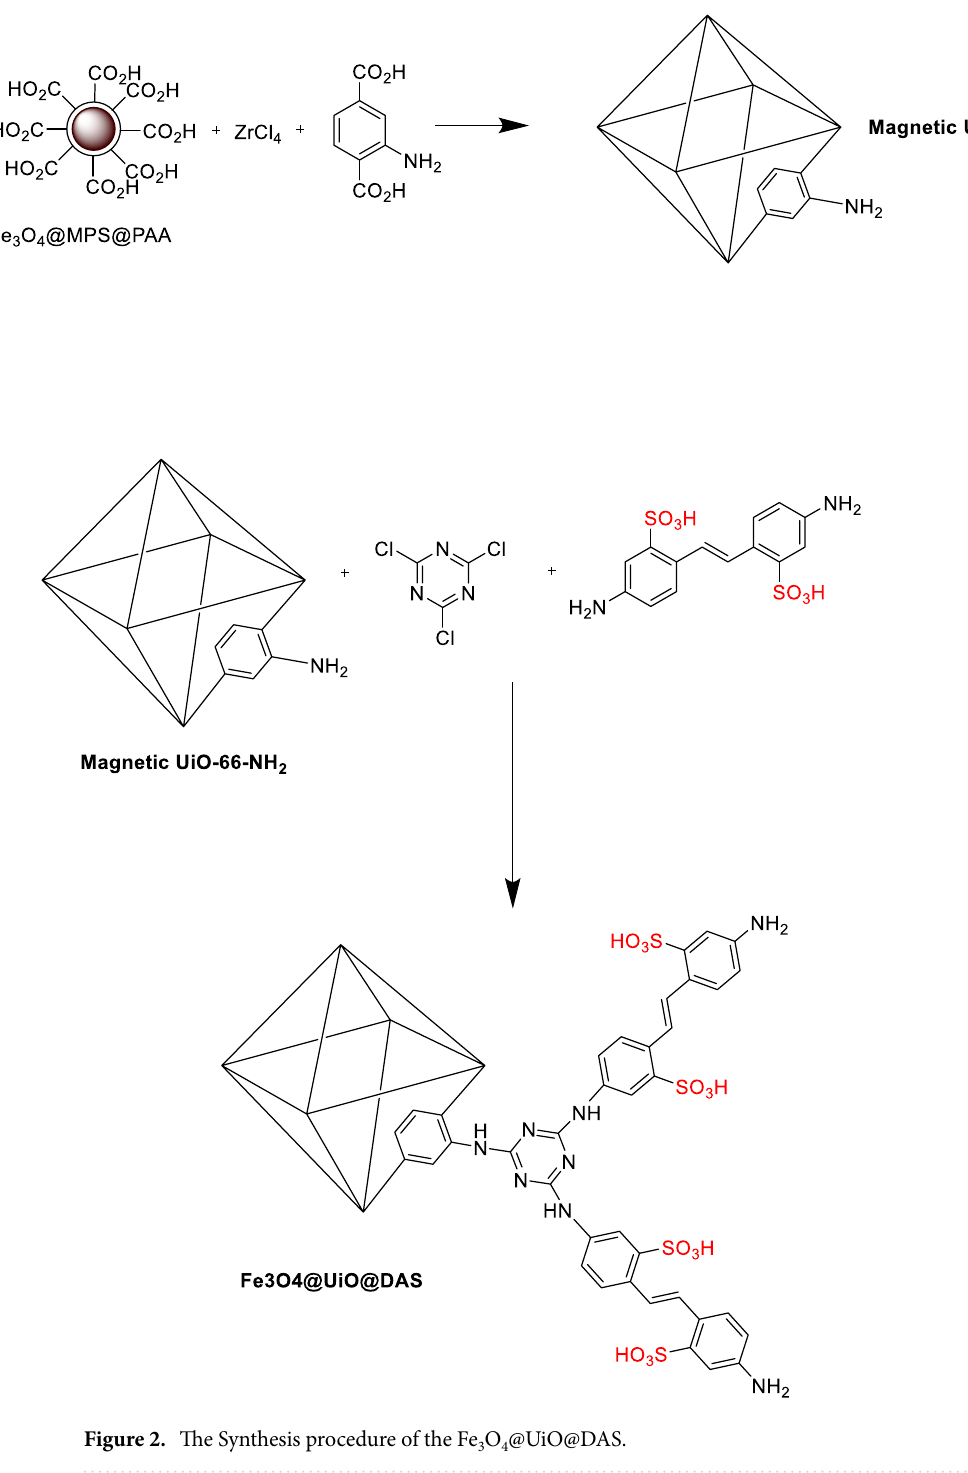
Figure 2. The Synthesis procedure of the Fe 3 O 4 @UiO@DAS.